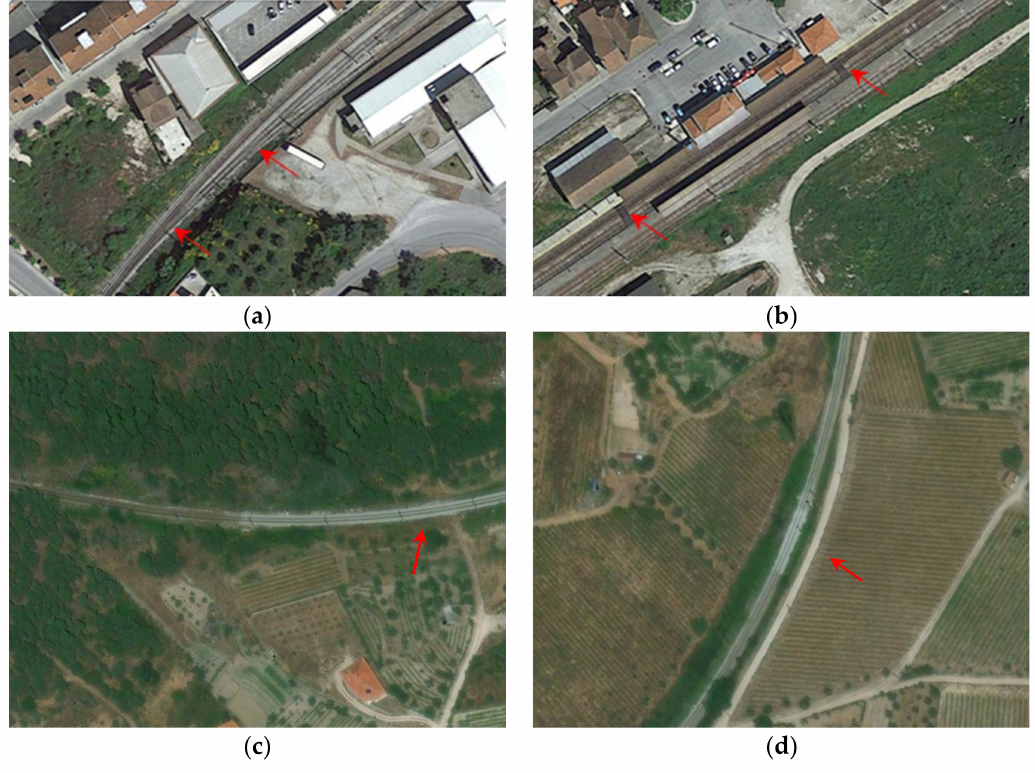
Figure 12. Events of the track: ( a ) two switches at about 3.8 km; ( b ) two level crossings in the station at about 4.1 km; ( c , d ) sections with newer ballast, at about 1.8 km and 7.0 km, respectively (Imagery © 2016